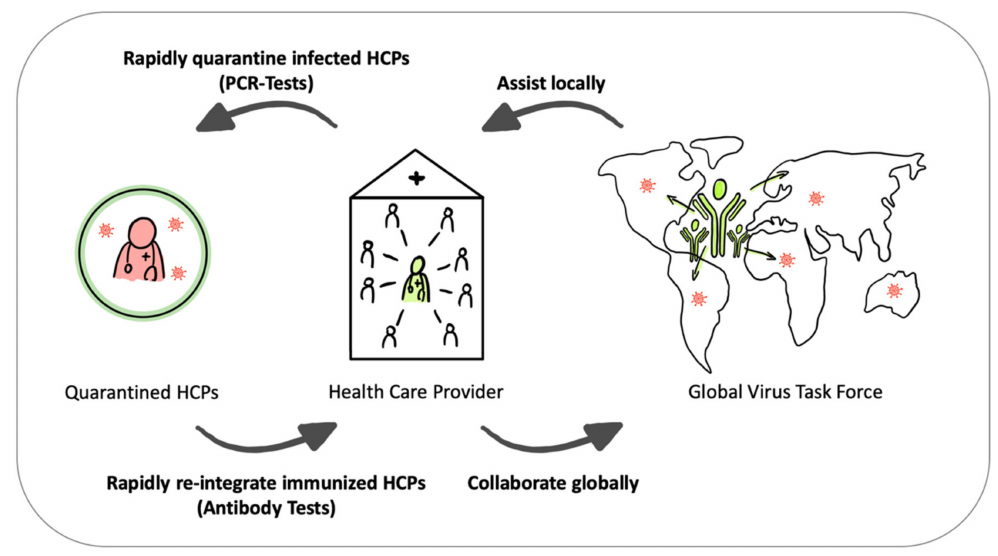
Figure 2. Virus task force without borders. On the left, more PCR tests allow for the rapid quarantining of infected HCPs, and antibody tests identify immunized HCPs to reintegrate them into the health care systems. On the right, international immune HCPs collaborate globally and assist locally in epidemic hotspots, as pathogens do not stop at national